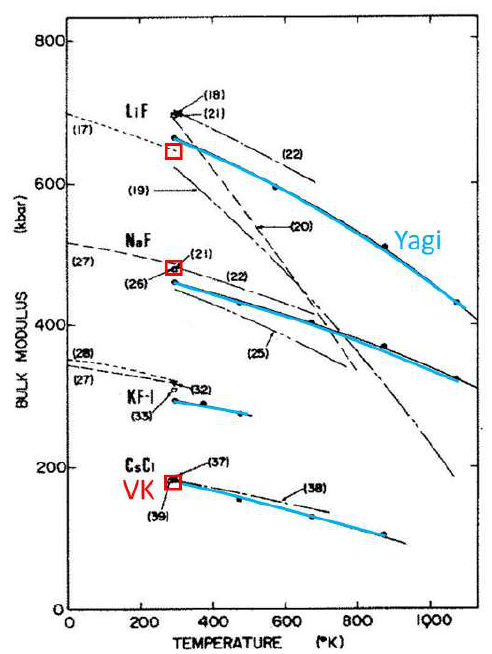
Figure 9. Bulk modulus of alkali halide as a function of temperature. Blue curves = EOS fits of Yagi [55] to his XRD data on LiF, NaF, the low- P B1 phase of KF, and CsCl with the B2 structure. Numbers in parentheses denote previous work cited by [55]. Red squares and “VK” = length change data [57], where too few data collections were made on KF to provide a reliable B T . Broken curves = acoustic data compiled by Yagi [55], where his references 19 and 20 are incompatible with other studies. For example, Hart [58] confirmed B aco ( T ) from curve 22 for NaCl, i.e., the work of Jones [59]. Modified after Yagi [55] (his Figure 8) with permission.